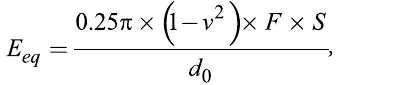
Fig. 1. SCI vs PDS of asphalt concrete surface of analyze group 2